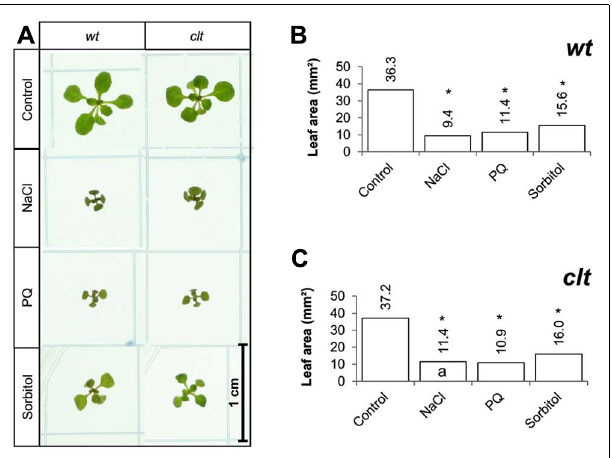
FIGURE 7 |A comparison of the effects of long-term (14 days) exposures to different abiotic stresses treatments on rosette leaf area in the clt1clt2clt3 triple mutants relative to wild type, Col-0 (wt). Phenotypes (A) and leaf area (B,C) of seedlings measured at 14 days either in the absence (control) or presence of the oxidative stress caused by the addition of paraquat (PQ) or, or high salt (sodium chloride, NaCl), or osmotic stress (sorbitol).The asterisks indicate significant differences ( p < 0.05;